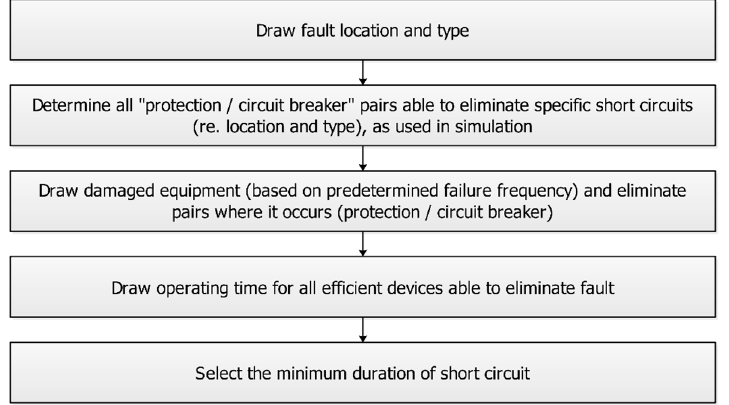
Figure3. StagesofdeterminingthevalueofshortcircuitdurationusingtheMonteCarlosimulationmethod. Energies 2020 , 13 , 970 Figure 3. Stages of determining the value of short circuit duration using the Monte Carlo simulation method.